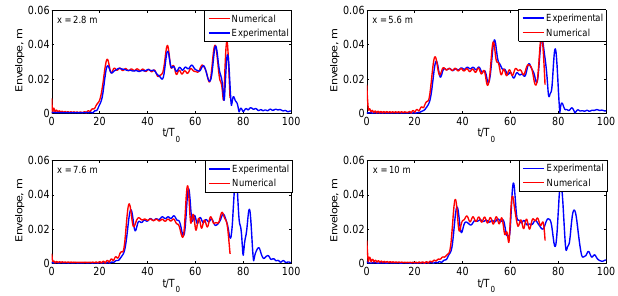
Figure 8. Comparison between the envelopes of the measured and numerical surface elevations η at various locations.